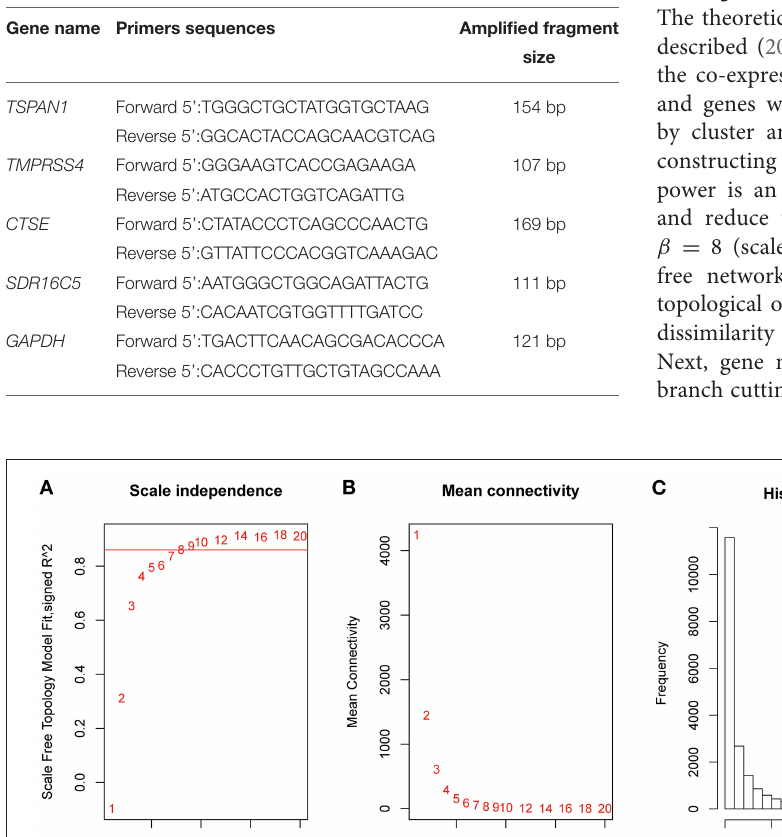
TABLE 1 | Primers sequences of hub genes and internal reference genes.